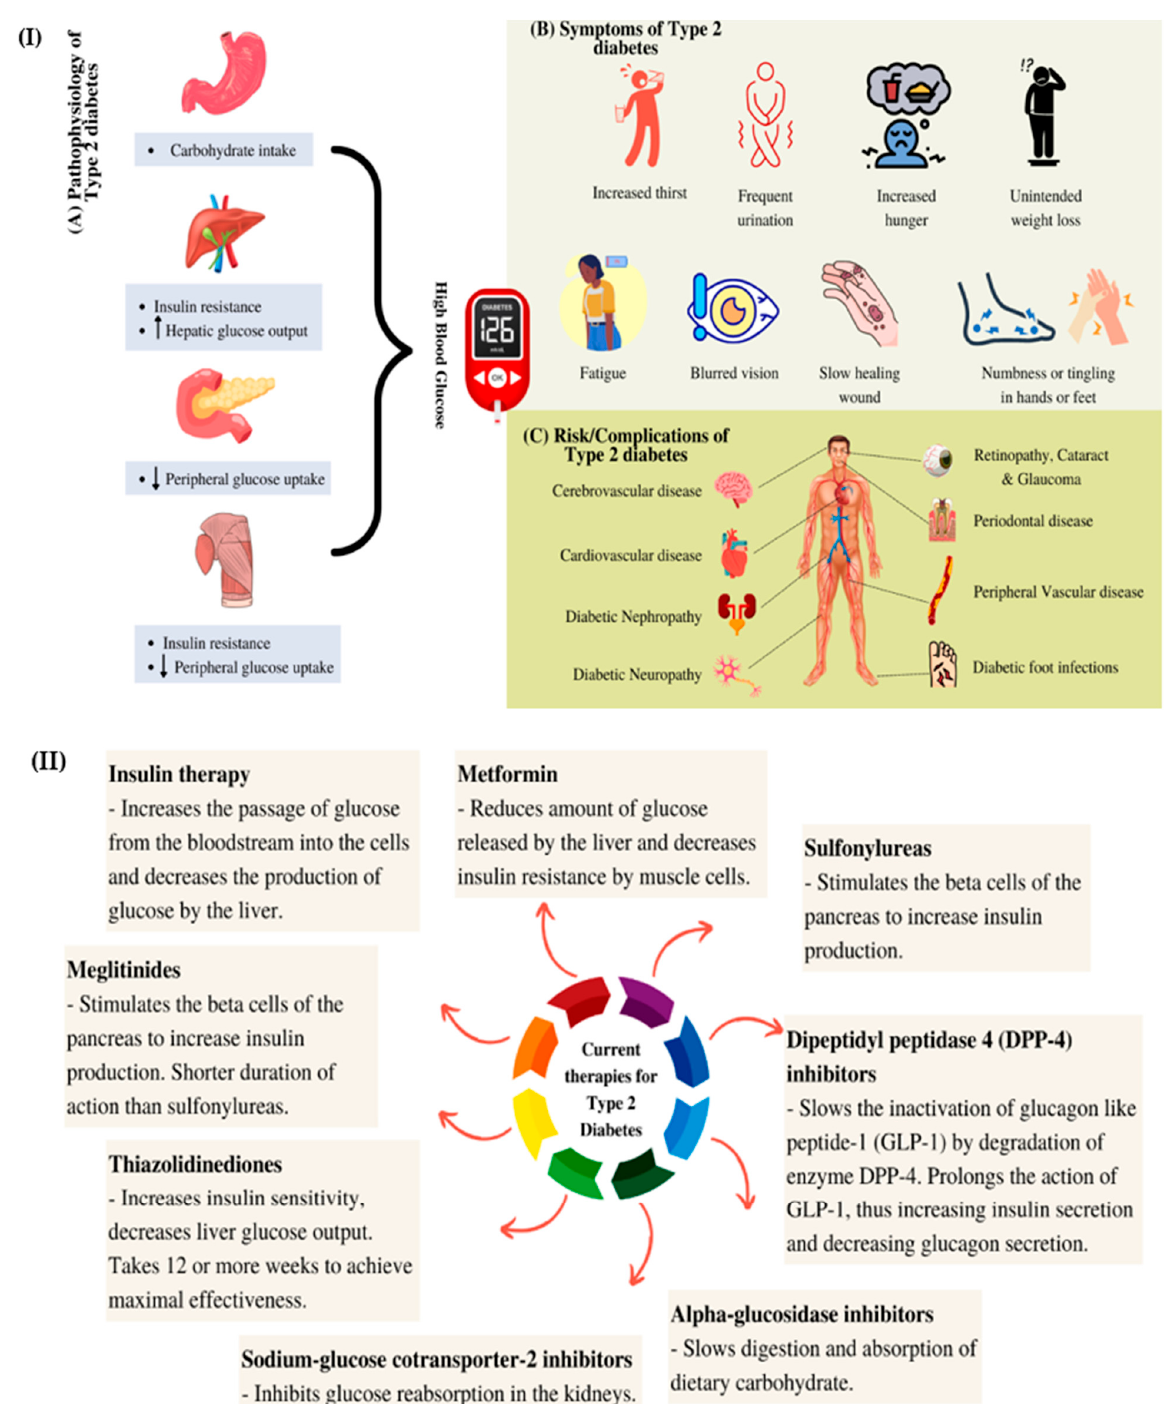
Figure 1. A schematic diagram representing ( I ) the aetiology and development of type 2 diabetes and ( II ) the current therapies for type 2 diabetes.